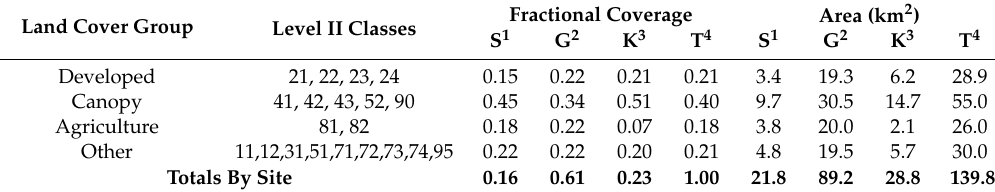
Table 3. Sample size in pixels, fractional coverage, and areas (km 2 ) for the three land cover groups of interest as well as the national land cover database (NLCD) Level II sub-classes used to define the land cover groups. The three study sites and the totals are listed for